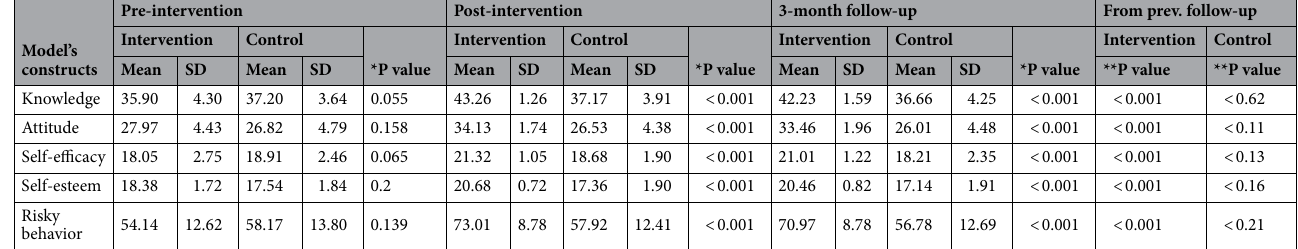
Table 4. Average scores for family-centered empowerment questionnaire’s constructs from baseline to follow up in control and intervention groups. n number of eligible participants, SD standard division; *Testing significant change between control and intervention groups; **Testing significant change from pre- intervention to 3-month